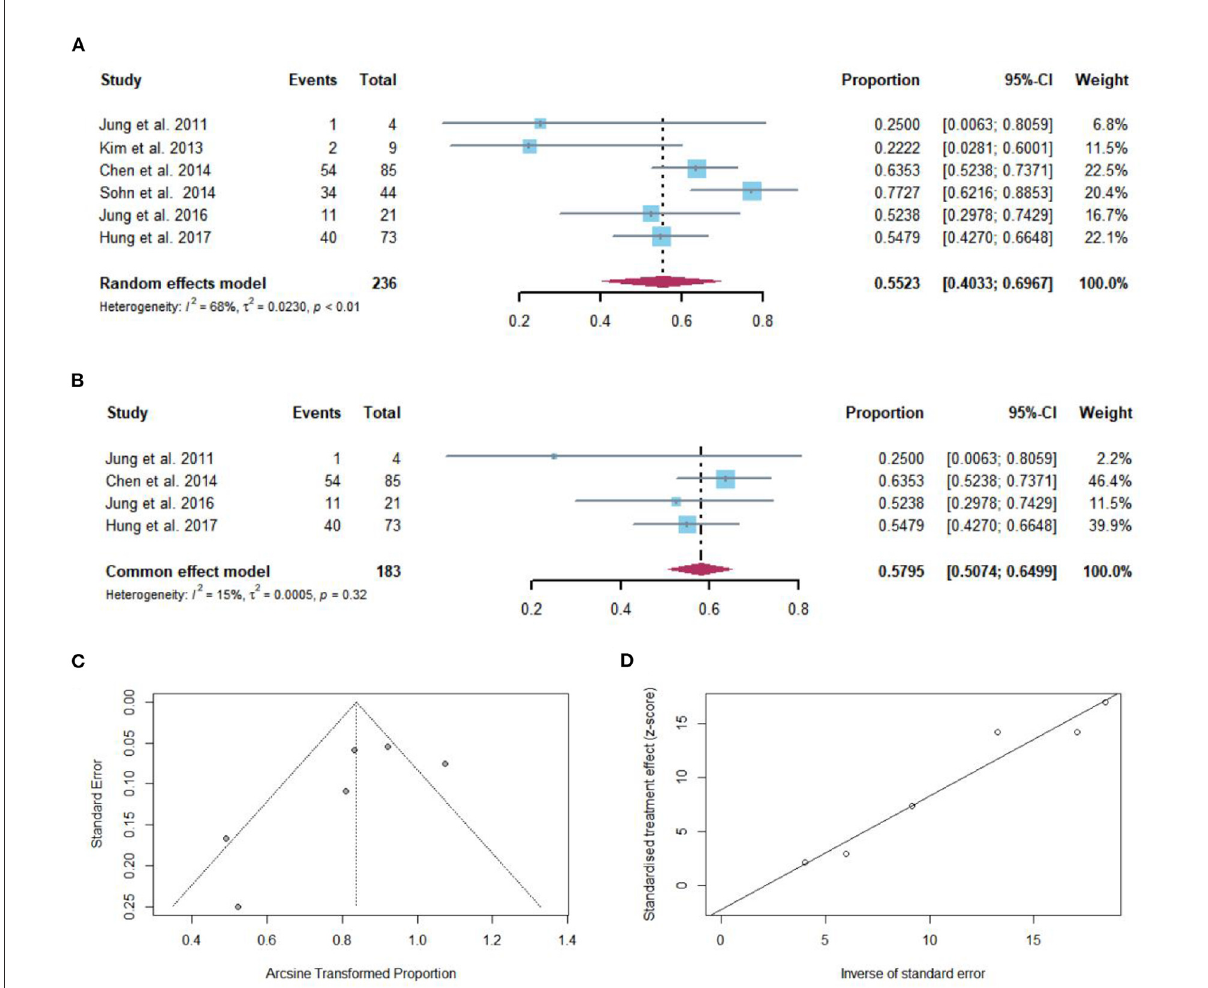
FIGURE2 (A) Individual estimate and pooled proportion of VR in cirrhotic patients after NAs discontinuation. (B) Sensitivity analysis of pooled proportion of VR in cirrhotic patients after NAs discontinuation excluding studies with high bias. (C) Funnel plot. (D) Egger’s test.